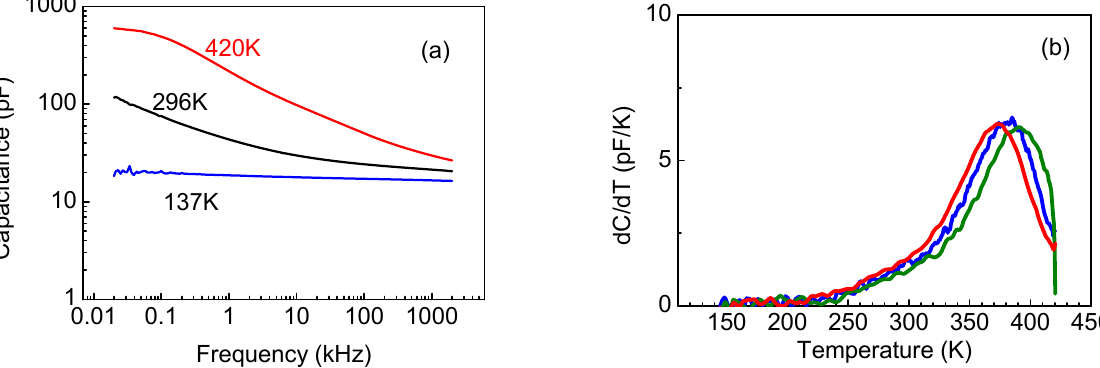
Figure 10. ( a ) C-f characteristics at three temperatures; ( b ) dC/dT for several measurement frequencies: 20 Hz (red), 30 Hz (blue) and 50 Hz (olive).